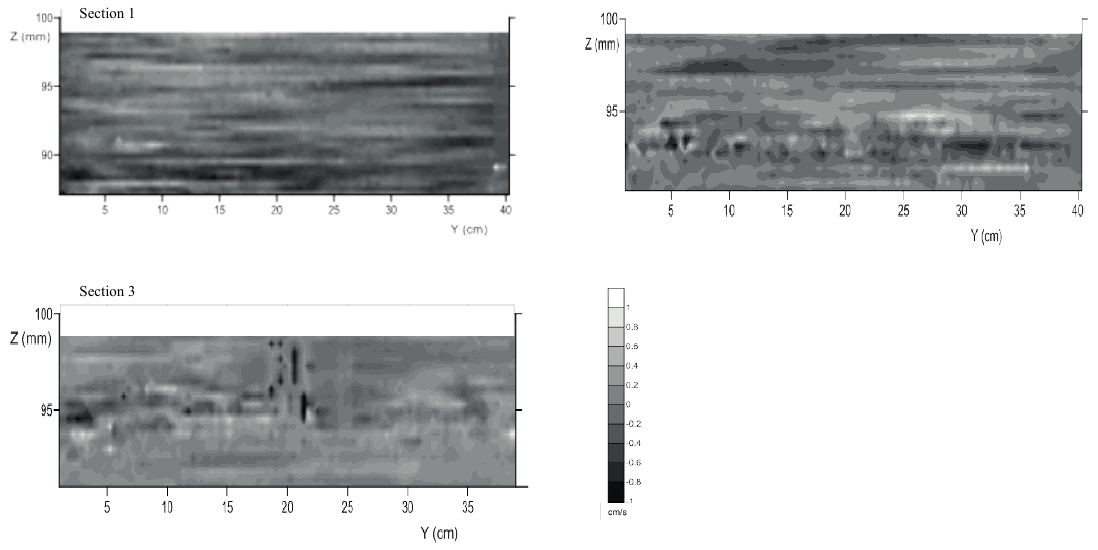
Fig. 8 Transversal velocity – WV run